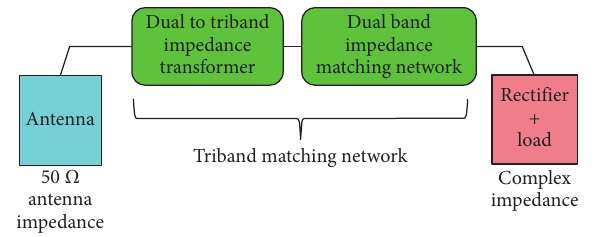
Figure 20: Block diagram of the Triband Impedance Matching Network